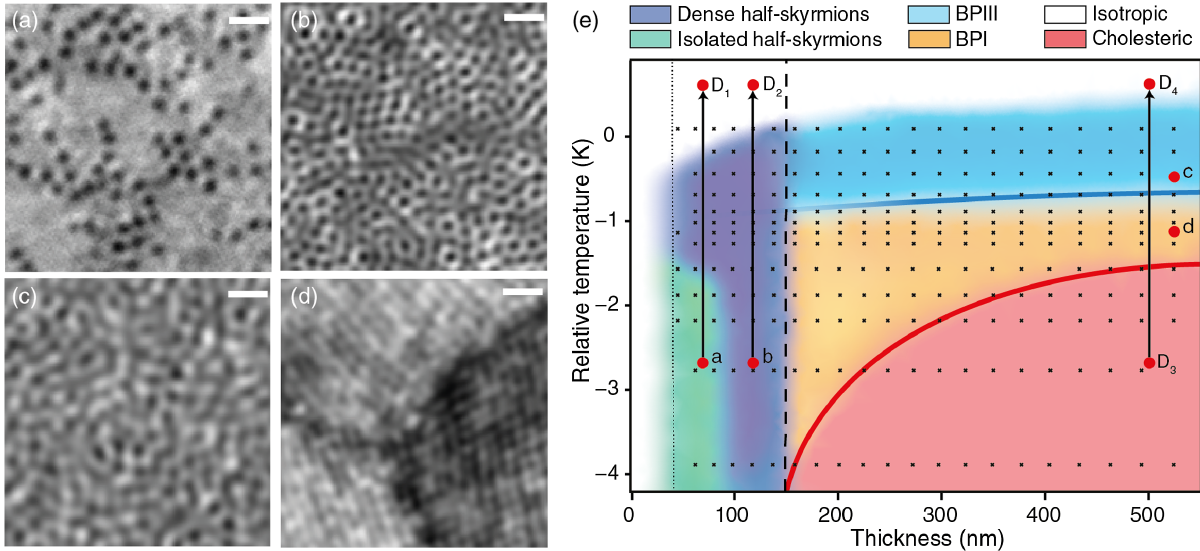
FIG. 5. Skyrmion phases in thin layers of a BPIII LC. (a) Isolated half-skyrmions are observed as approximately 120-nm-diameter dark spots at temperatures well below the BPIII phase for thicknesses less than approximately 80 nm. The dark spots are the centers of half-skyrmions; the size of the spots is determined by the diffraction limit of the microscope. (b) A dense and disordered phase of half- skyrmions is observed in the thickness range approximately 80 to approximately 150 nm. (c) BPIII is a stable phase above the critical thickness of approximately 150 nm. (d) BPI is also stable above the critical thickness of 150 nm. (e) The thickness-temperature ð d; T Þ phase diagram, as determined by heating the LC. Each black cross represents an image taken; the structures are identified from the images. Below the thickness denoted by the dotted line, no structures are observed. The blue line is a BPIII-BPI phase boundary that is of first order at large thicknesses. The red line is a first-order phase boundary between the BPI and the cholesteric phase that ends in a triple point, where the BPI, skyrmion, and cholesteric phases coexist. The lines a - D 1 , b - D 2 , and D 3 - D 4 represent the temperature scans in Figs. 6(a) – 6(c). Scale bars in (a) – (d) indicate 500 nm. Images of different skyrmion phases in (a) – (d) are taken at a - d positions marked on the phase diagram in